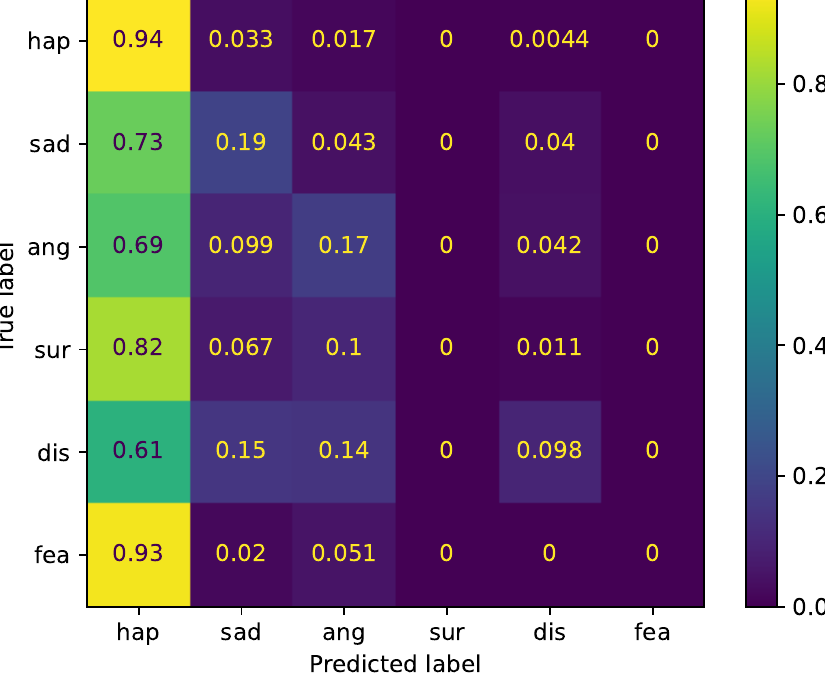
Figure 4. Normalized confusion matrix for six-class emotion